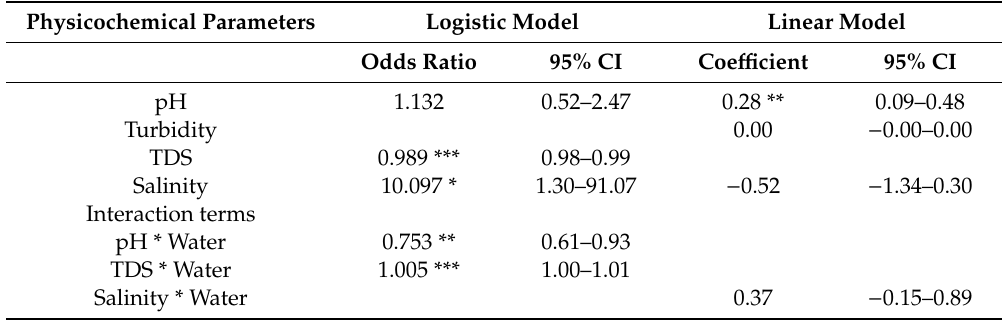
Table 2. Estimated regression parameters (odds ratio and confidence interval) in the final logistic and parameters (coefficient and confidence interval) in the final linear models on the chance and probability of finding a positive sample and log10 concentration of Leptospira , respectively. (***) p < 0.01, (**) p < 0.05, (*) p < 0.1.